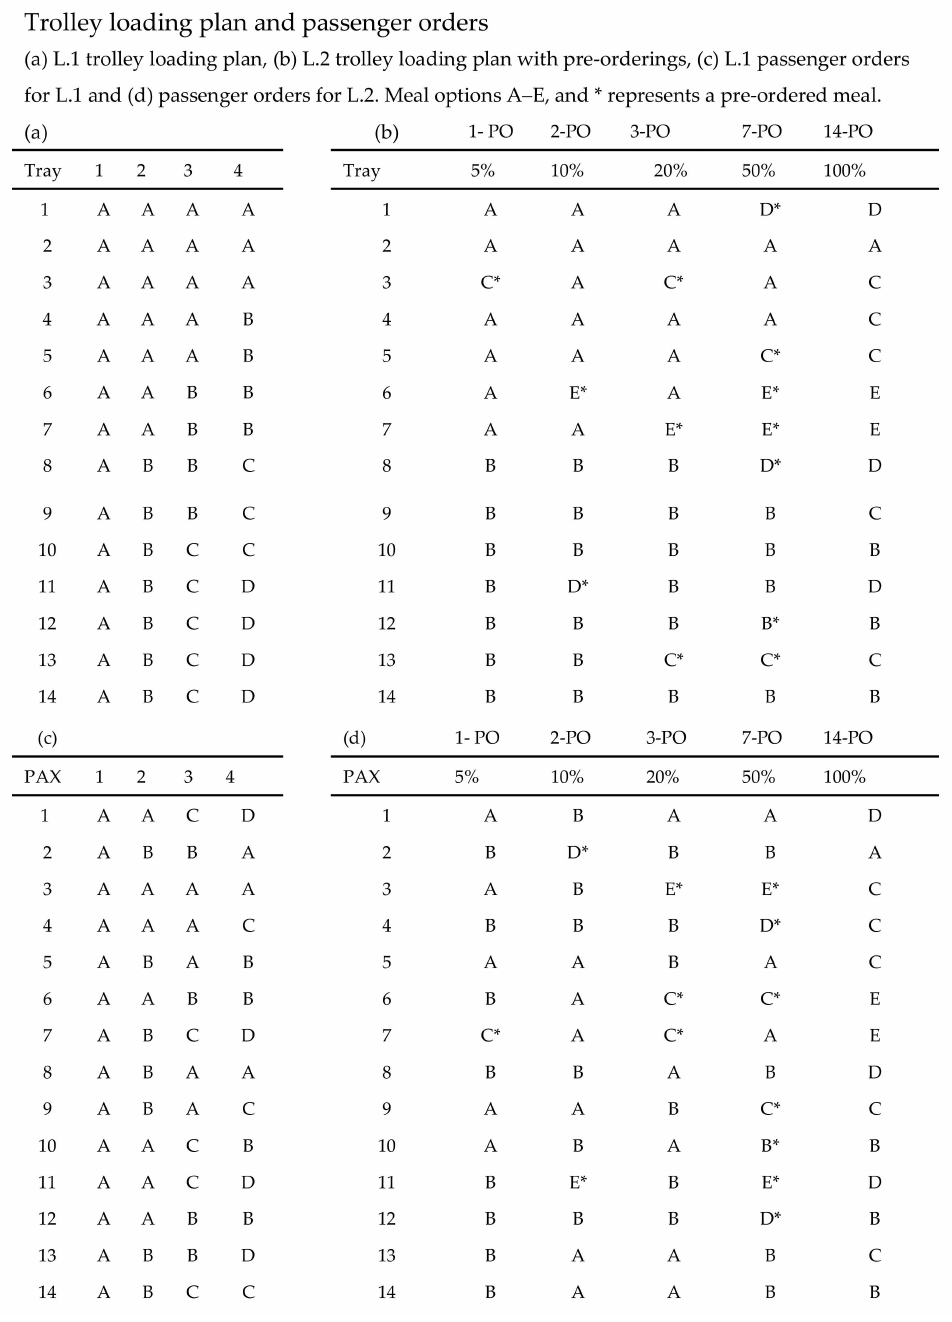
Figure 20. Trolley loading plan and passenger